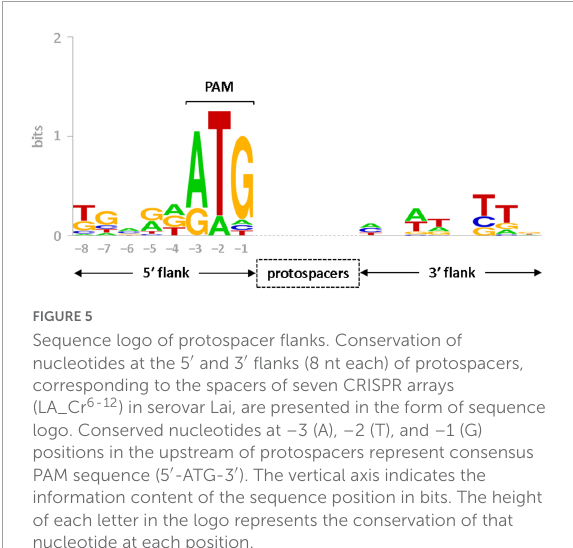
FIGURE5 Sequence logo of protospacer flanks. Conservation of nucleotides at the 5 (cid:48) and 3 (cid:48) flanks (8 nt each) of protospacers, corresponding to the spacers of seven CRISPR arrays (LA_Cr 6 - 12 ) in serovar Lai, are presented in the form of sequence logo. Conserved nucleotides at –3 (A), –2 (T), and –1 (G) positions in the upstream of protospacers represent consensus PAM sequence (5 (cid:48) -ATG-3 (cid:48) ). The vertical axis indicates the information content of the sequence position in bits. The height of each letter in the logo represents the conservation of that nucleotide at each